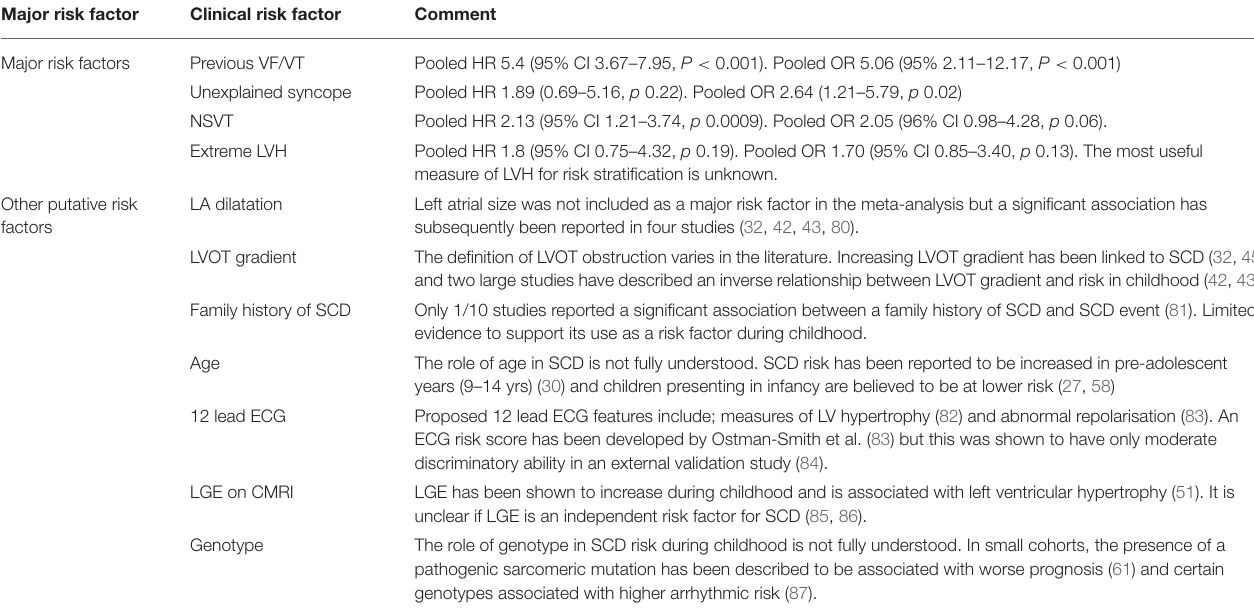
TABLE 3 | Risk factors for sudden cardiac death in childhood